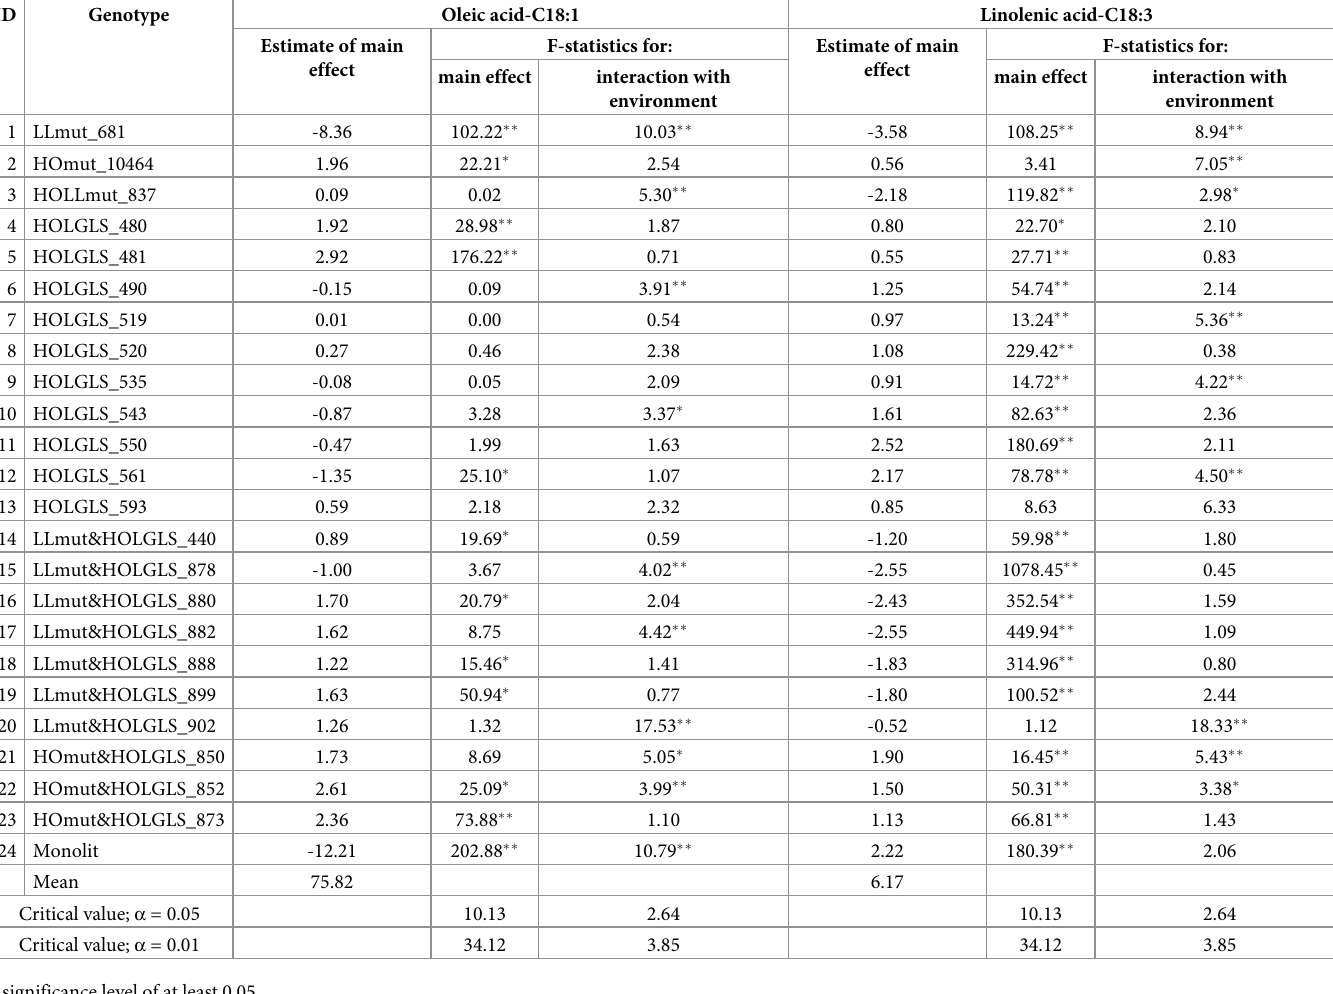
Table 4. Genotype x environment interaction estimated for C18:1 and C18:3 fatty acids content in seed oil.